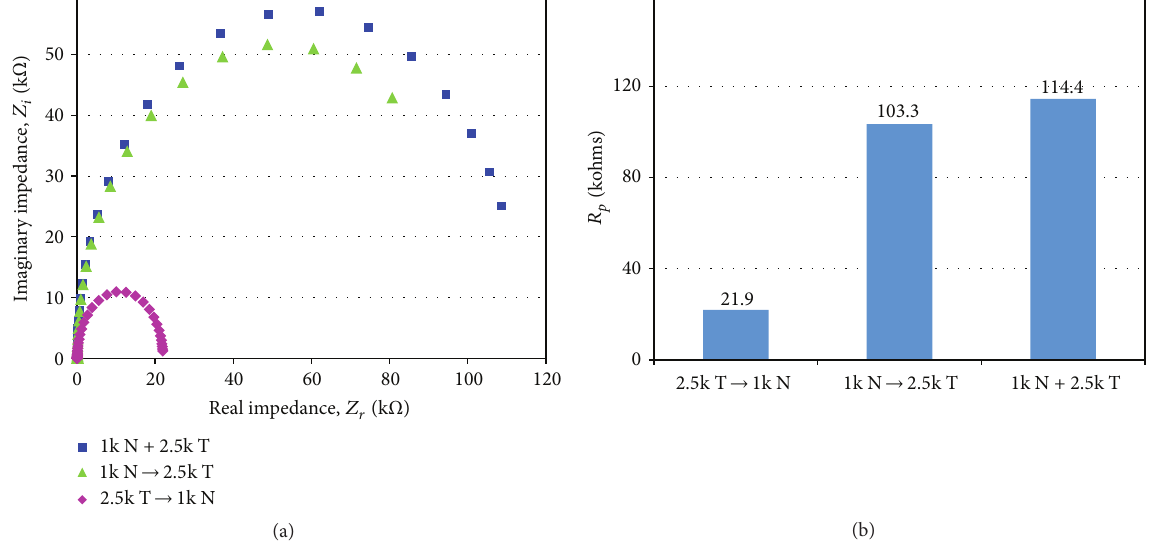
Figure 12: Effect of addition sequence of corrosion inhibitors (N: ppm NO 2− , T: ppm TEA) on AC impedance of the passive film that was formed at 0V (SCE) in deaerated tap water at 25 ∘ C. (a) Nyquist plot. (b) 𝑅 𝑝